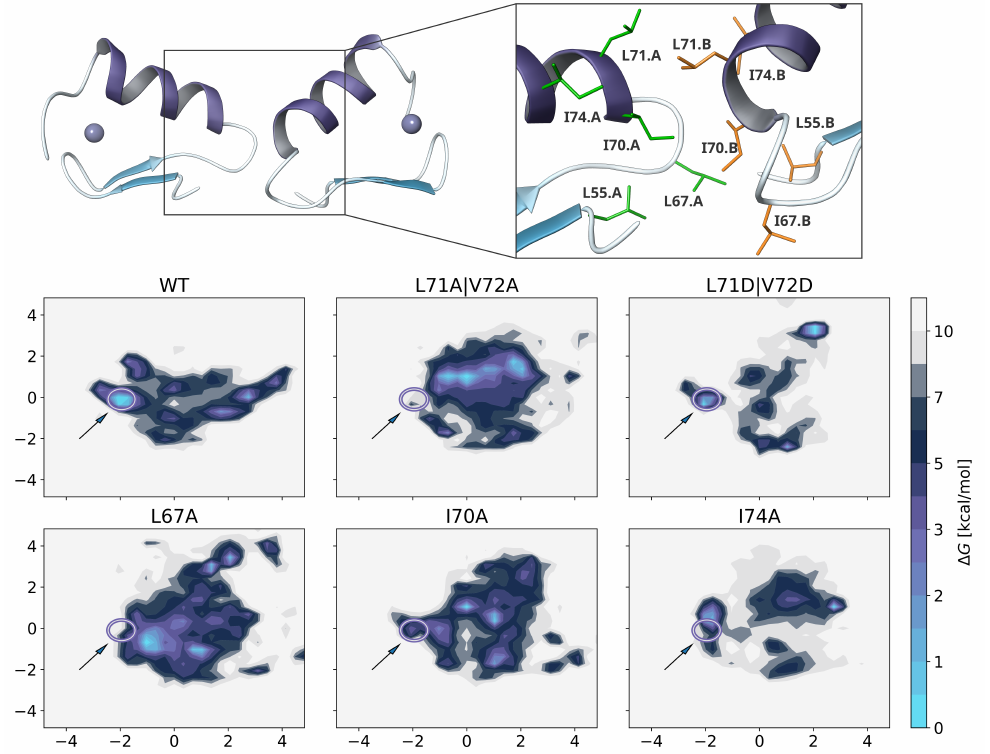
Figure 5. Free energy landscapes obtained from TIGER2h protein-protein docking simulations for selected mutants, marked in Figure 4. The circle highlights the minimum wild-type structure based on pairwise backbone atom distance PCA, and is shown above. Similar structures appear at similar spots on the conformational landscape, due to injection of the WT principal axes for also the mutant constructs. Interface residues and orientation of the truncated wild-type conformation is similar to the full-length zinc finger protein (Figure 3) and was used as